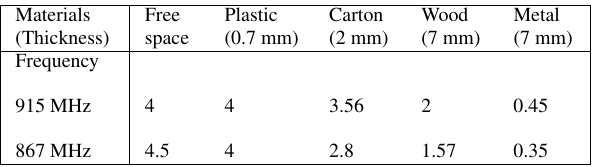
FIGURE 13: Read range measurement on different objects. TABLE 2: Measured reading range for different materials (m).